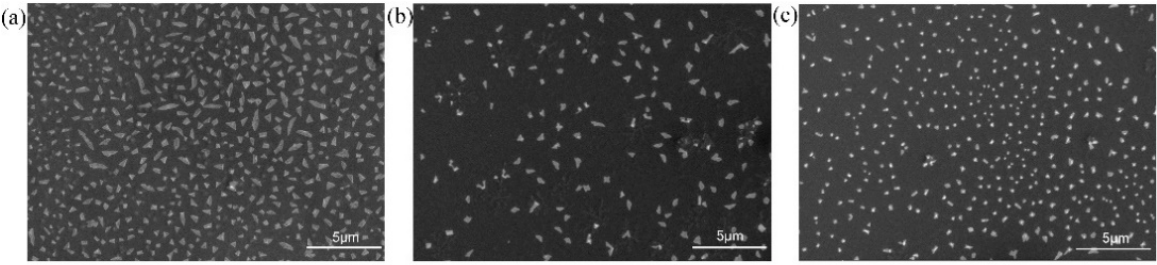
Figure 5. SEM images of the membrane-like nanomaterials from the mixture of 6Nce-6Noc/6Nae-6Noc (1/1) ( a ) before, ( b ) 15 min after and ( c ) 30 min after sonication.